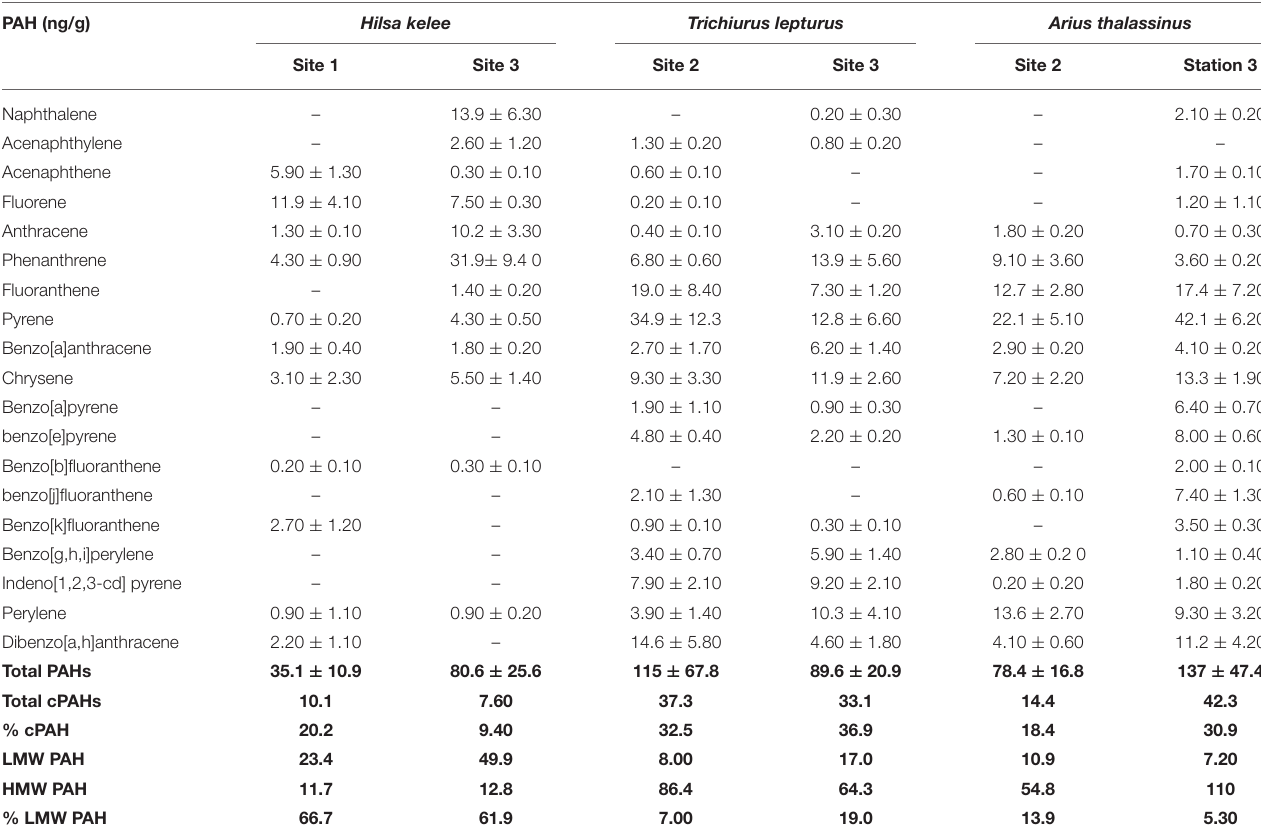
TABLE 3 | Concentration (in ng/g) of the 19 individual PAHs, total PAHs, total cPAHs (which represents the total concentration of carcinogenic PAHs + including BaA, Chr, BbF, BkF, BaP, IP, and DahA), LMW PAHs with 2 and 3 rings, HMW PAHs with 4, 5, and 6 rings), and % LMW PAH in samples of three dominant teleost from their respective collection sites in the Rufiji